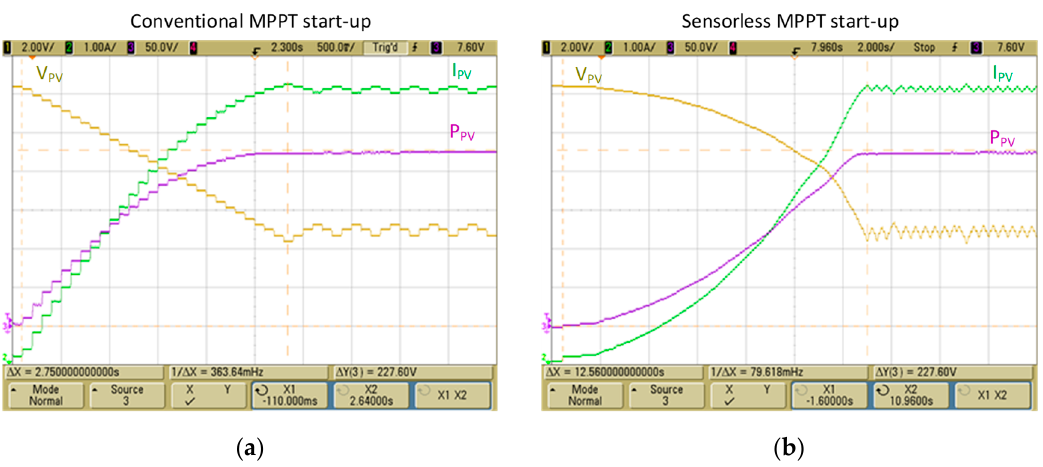
Figure 17. MPPT response from the start-up until the MPP is reached. F MPPT : 10 Hz. ( a ): Conventional, V PV step: ∆ V PV_Ref = 300 mV. ( b ): Sensorless, PCC Vc step: ∆ Vc = 12.5 mV ( ≈ 250 mA close to the MPP).